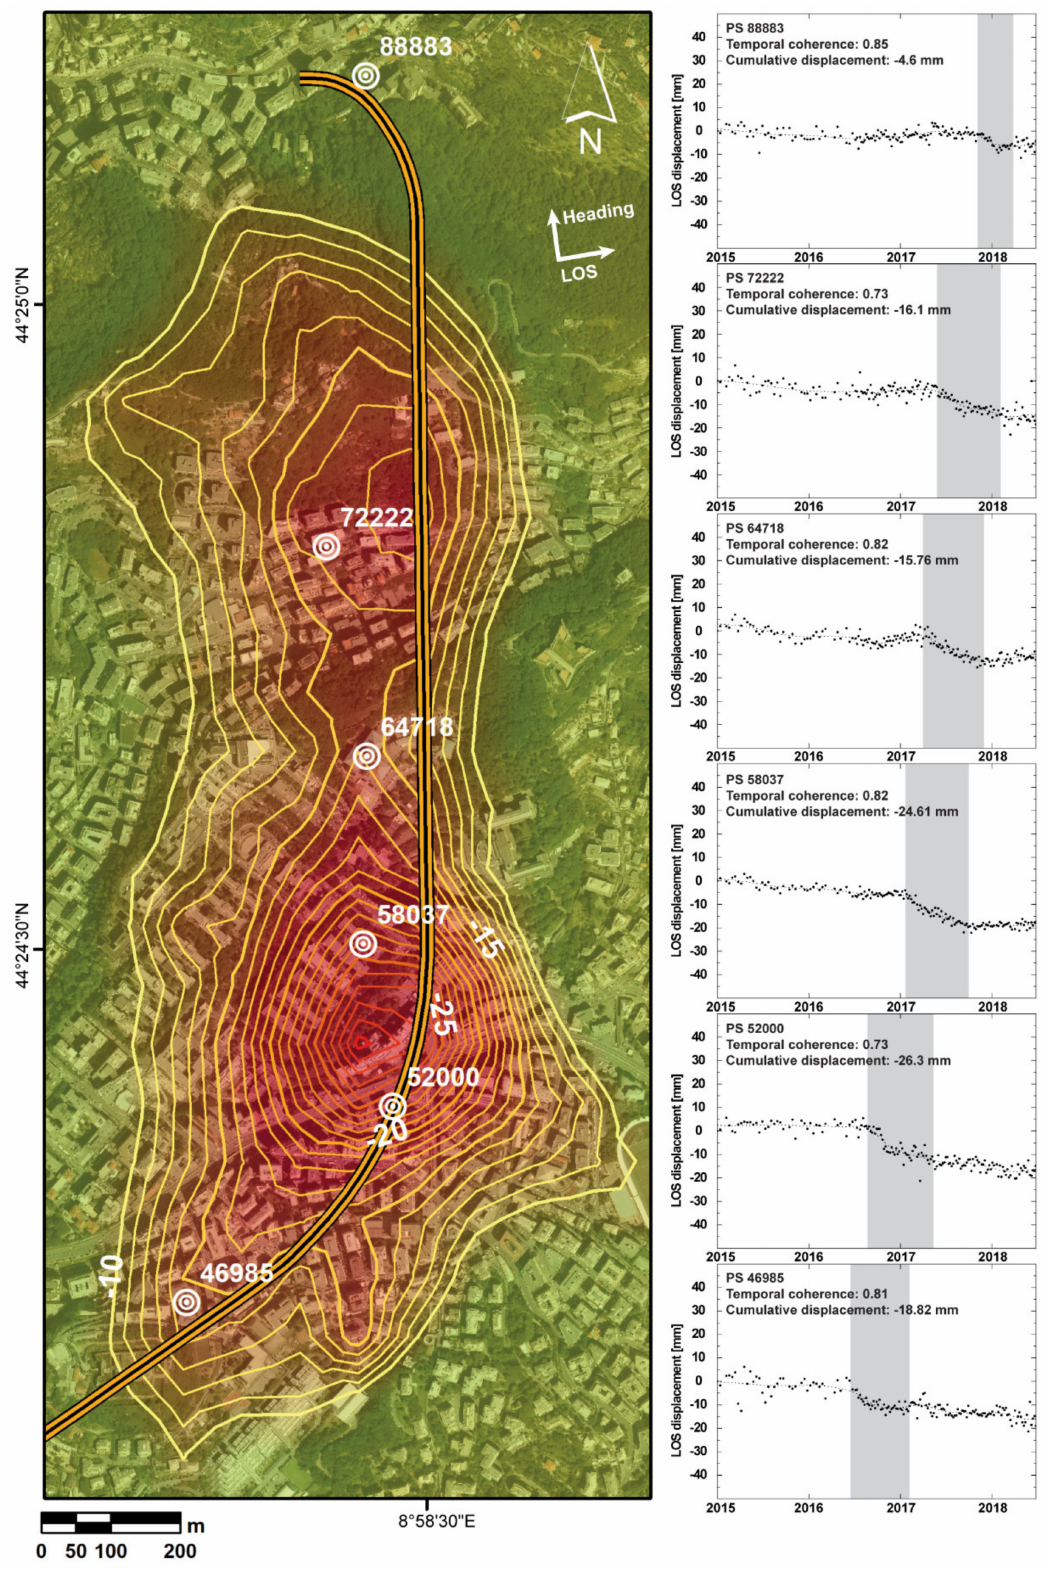
Figure 8. Contour map of cumulative displacement (LOS ascending direction, mm). The targets indicate the location of the PSs selected to show in the related time series (on the right). The T.S. graphs show the progressive deformation along the tunnel